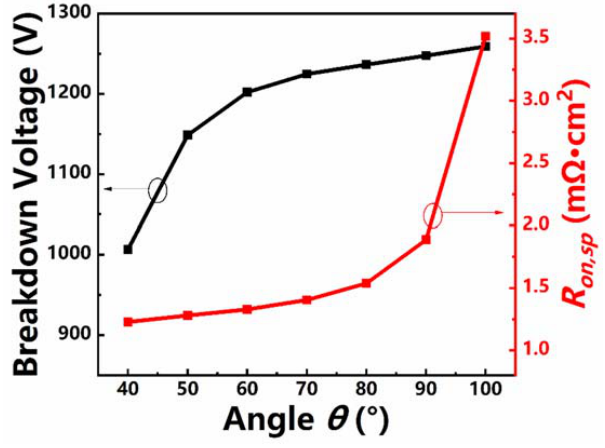
Figure 7. Breakdown voltage and on-resistance of the TJBS diodes as a function of the variation of the angle ( θ ) of the trench slope.